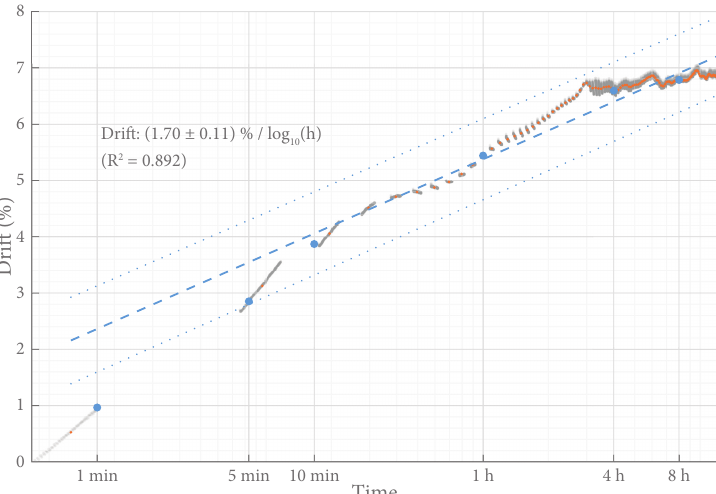
Figure 9. Time drift. The results of a typical static load test, during the loaded period, with time on the x -axis on a logarithmic scale. Orange dots represent the observed drift. A best linear fit and its 95% prediction interval is presented as a blue line. The blue dots represent the drift at specific times, as per Parmar et al.’s [3]